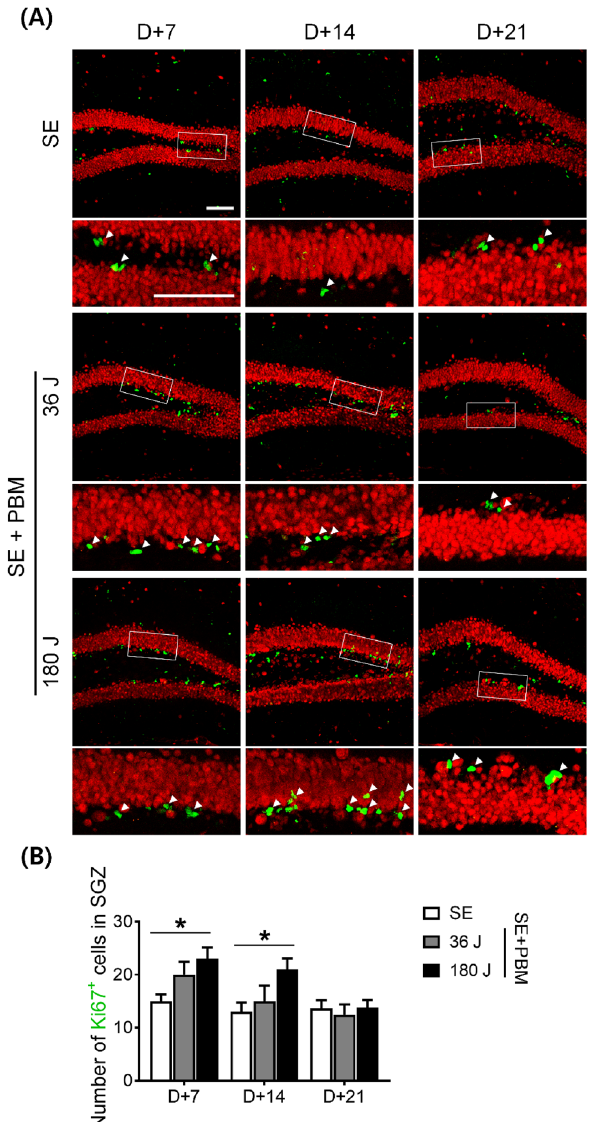
Figure 3. PBM increased cell proliferation in the SGZ of the DG on the hippocampus after SE. ( A ) Representative coronal section views of Z-stacks obtained by confocal microscopy show the localization of Ki67 positive cells (white arrow head, proliferated cells) in the SGZ of the DG. Scale bar 100 µm. Immunostaining was performed with NeuN (for mature neuron, red) and Ki67 (for proliferating cell, green). The insets are enlarged images of the boxed region. Scale bar 100 µm. ( B ) Quantification of the number of proliferated cells in the SGZ is shown. In the SGZ, proliferated cells increased in the PBM treated groups compared to the SE group in 180 J PBM at 7 and 14 days not at 21 day. The quantitative data are presented as the mean ± SEM. *P < 0.05 compared with to SE group. This figure was generated with Microsoft Visio version 2016 (Microsoft, Redmond, WA,